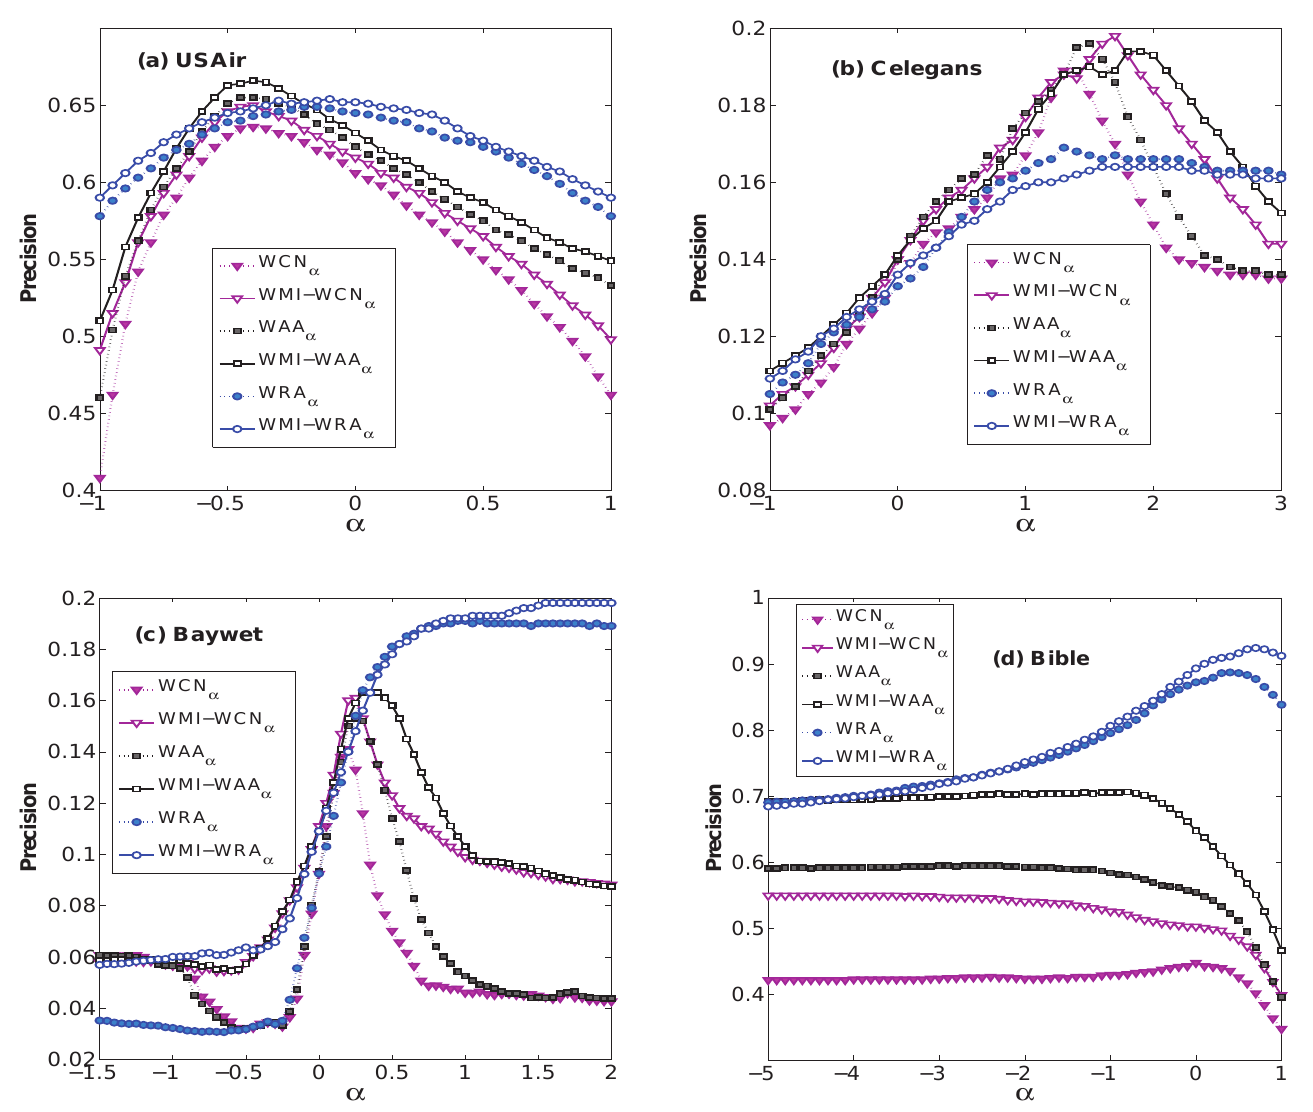
Fig 1. The performances of WMI-based methods and other three weighted indices with different α on the four real-world networks.